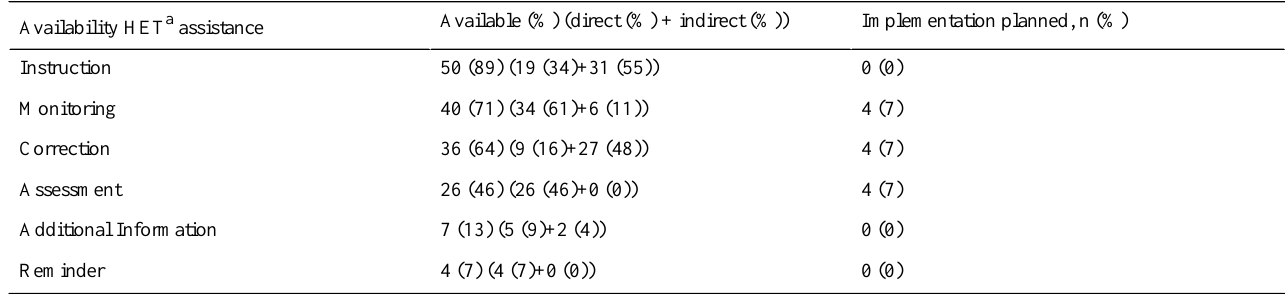
Table 2. Assistance options in descending order of